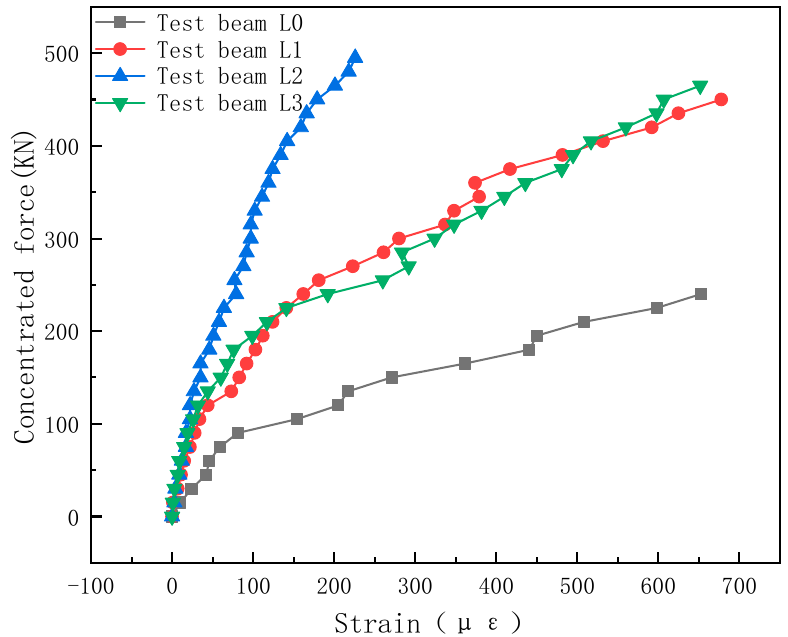
Figure 14. Load and strain at the bottom of the test beams.